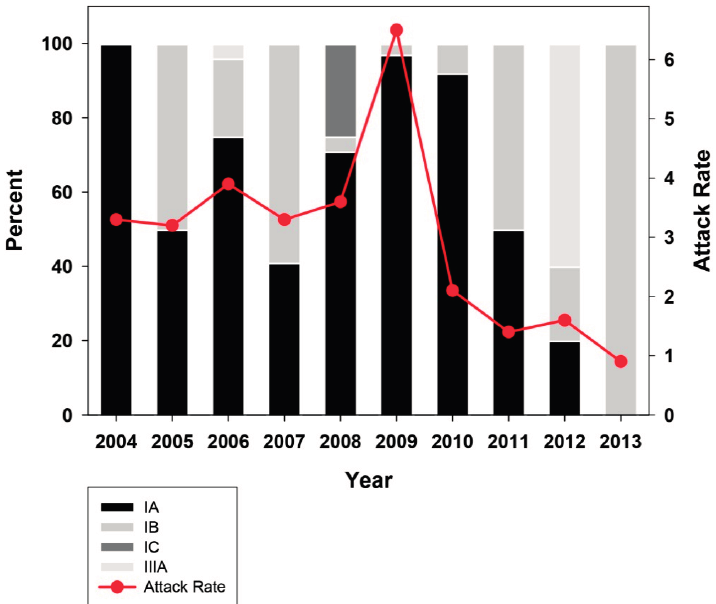
Figure 5. Distribution of HAV genotypes in Catalonia, Spain, in the decade